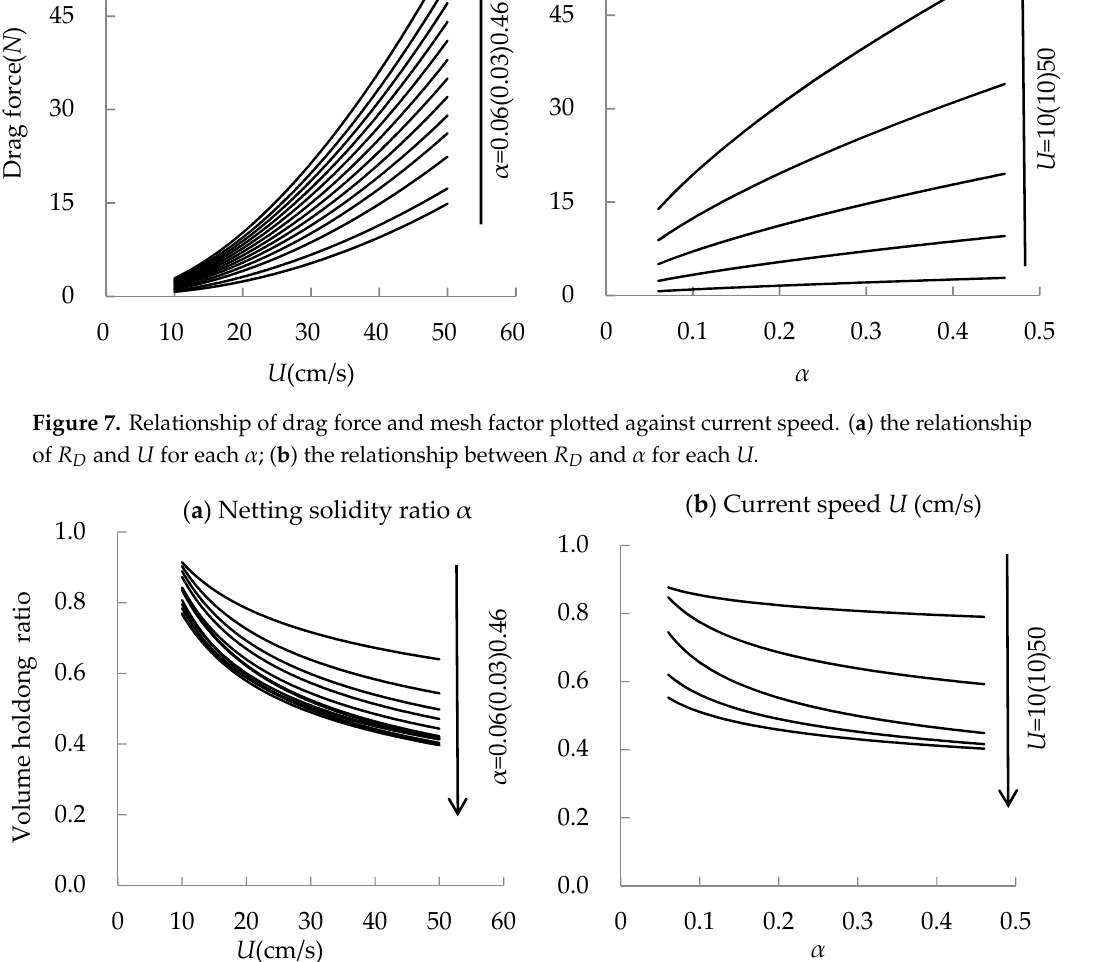
Figure 7. Relationship of drag force and mesh factor plotted against current speed. ( a ) the relationship of R D and U for each α ; ( b ) the relationship between R D and α for each U.